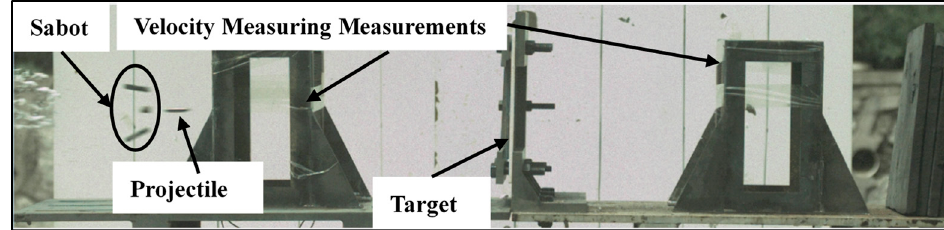
Figure 3. The high-speed camera images of the projectile impacting the target.